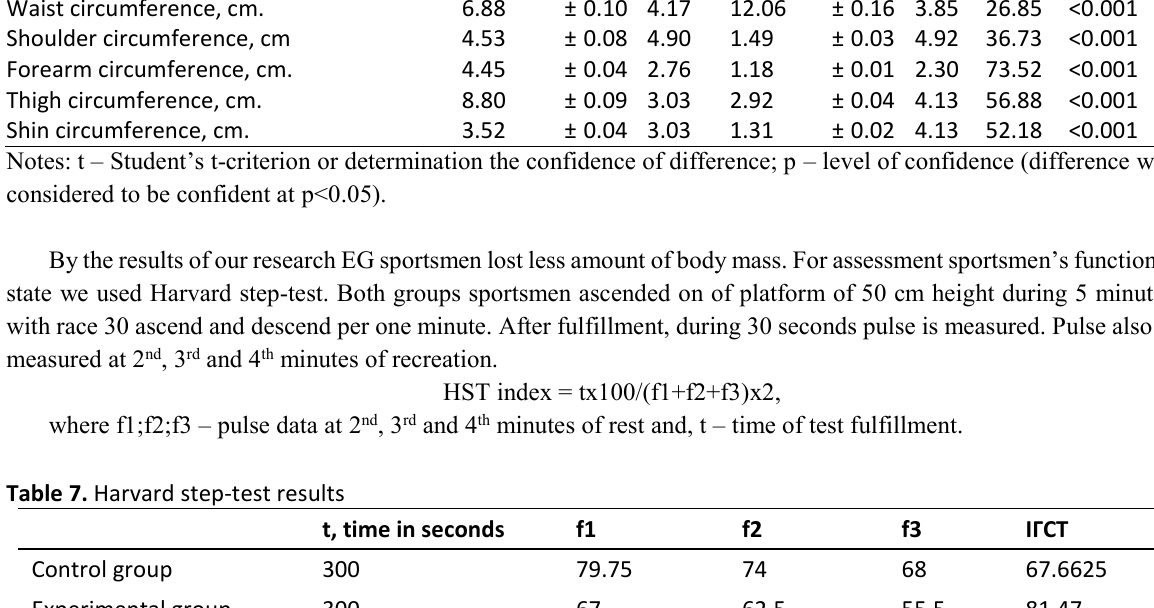
Body mass, kg. Neck circumference, cm.